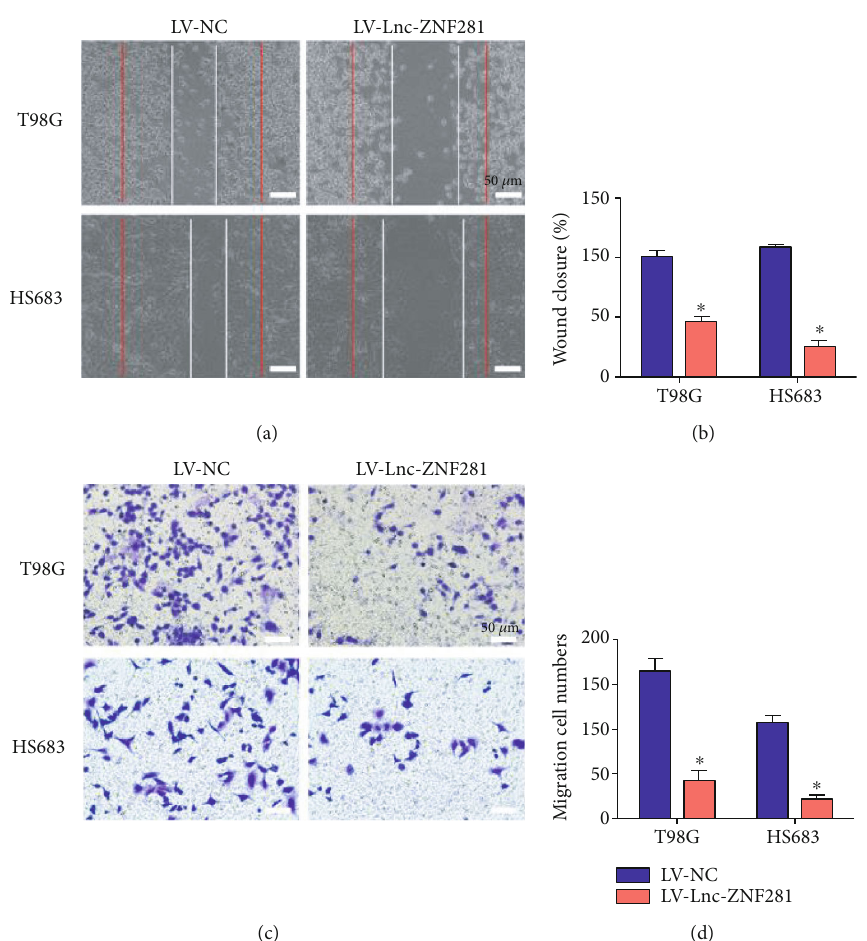
Figure 3: Overexpression of lnc-ZNF281 inhibited glioma cell migration. (a, b) The wound-healing assay results revealed that overexpression of lnc-ZNF281 inhibited cell migration in glioma. Images were acquired at 0 h (red line) and 24 h (white line). (c, d) The transwell assay results indicated that overexpression of lnc-ZNF281 inhibited cell migration in glioma. Scale bars = 50 μ m. ∗ p < 0 : 05